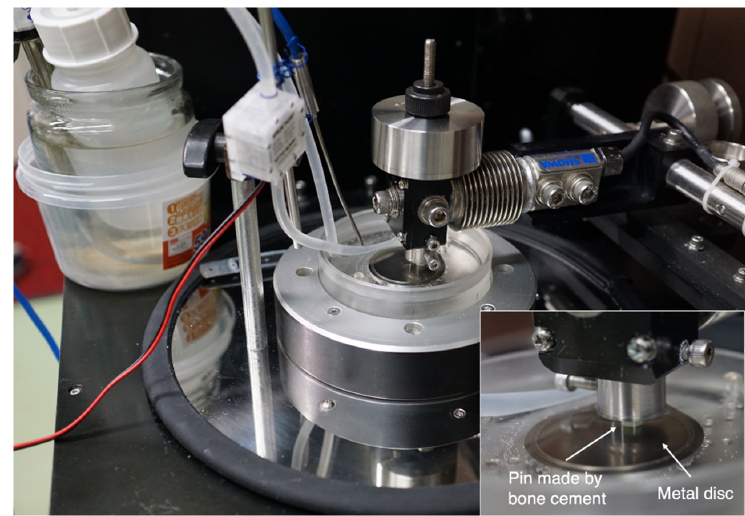
Figure 5. Photograph of the tribological experiments using a pin-on-disc tribometer (RHESCA Co., Ltd., Tokyo, Japan). The inset is a magnified view of the pin-on-disc tribometer.